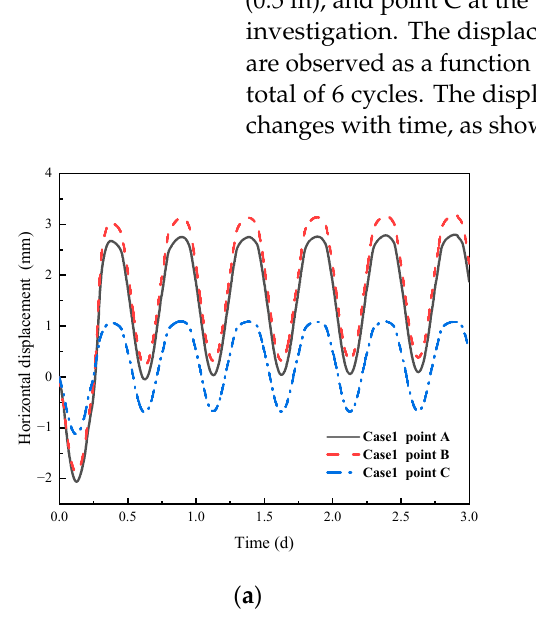
Figure 9. Time-history curves of the horizontal displacement of three characteristic points (indicated in Figure 8) of the No. 1 pile under three cases: ( a ) Horizontal displacement of feature points in 3 d due to tidal action. ( b ) Horizontal displacement of feature points when the water level rises and drops suddenly.